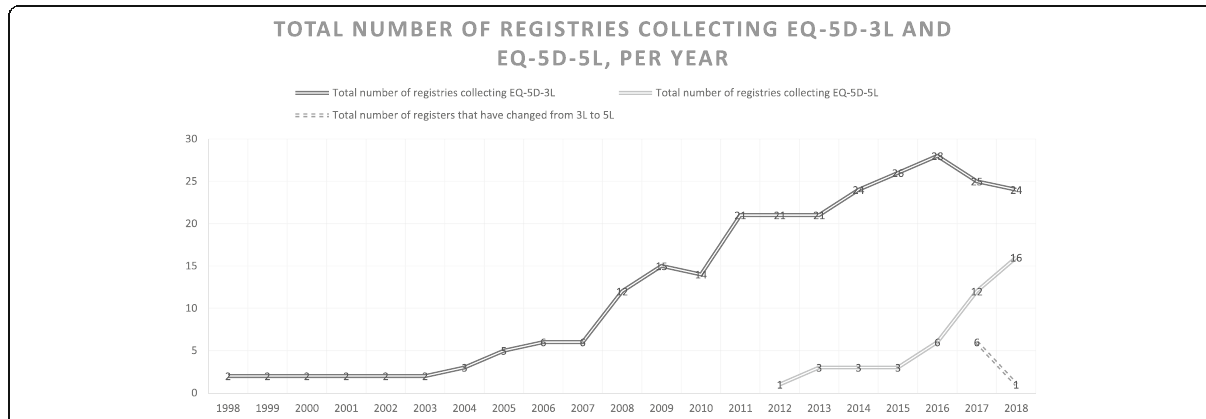
Fig. 2 Number of registries collecting EQ-5D-3L and EQ-5D-5L, per year (1998 –